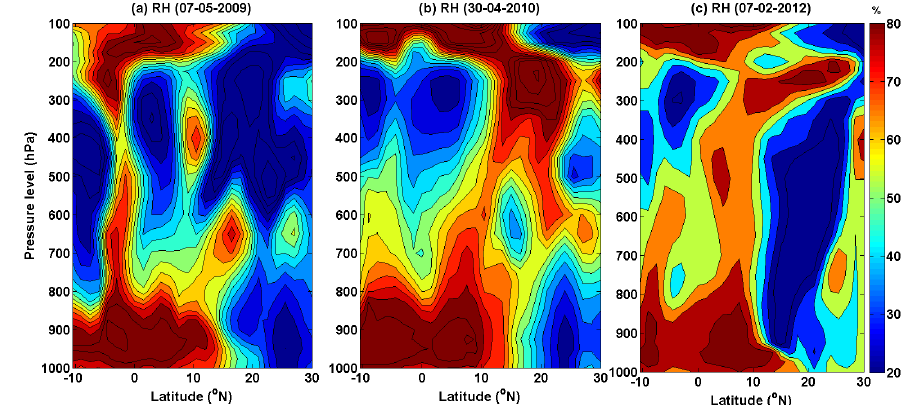
Figure 8. Latitude-height cross section of RH for the days 7 May 2009, 30 April 2010 and 7 February 2012.